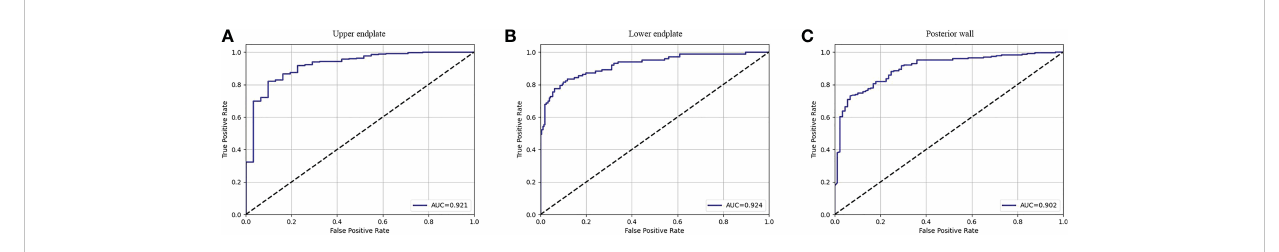
FIGURE 5 The ROC curve of fracture involvement detection in the test dataset for the upper endplate (A) , lower endplate (B) and posterior wall (C) .